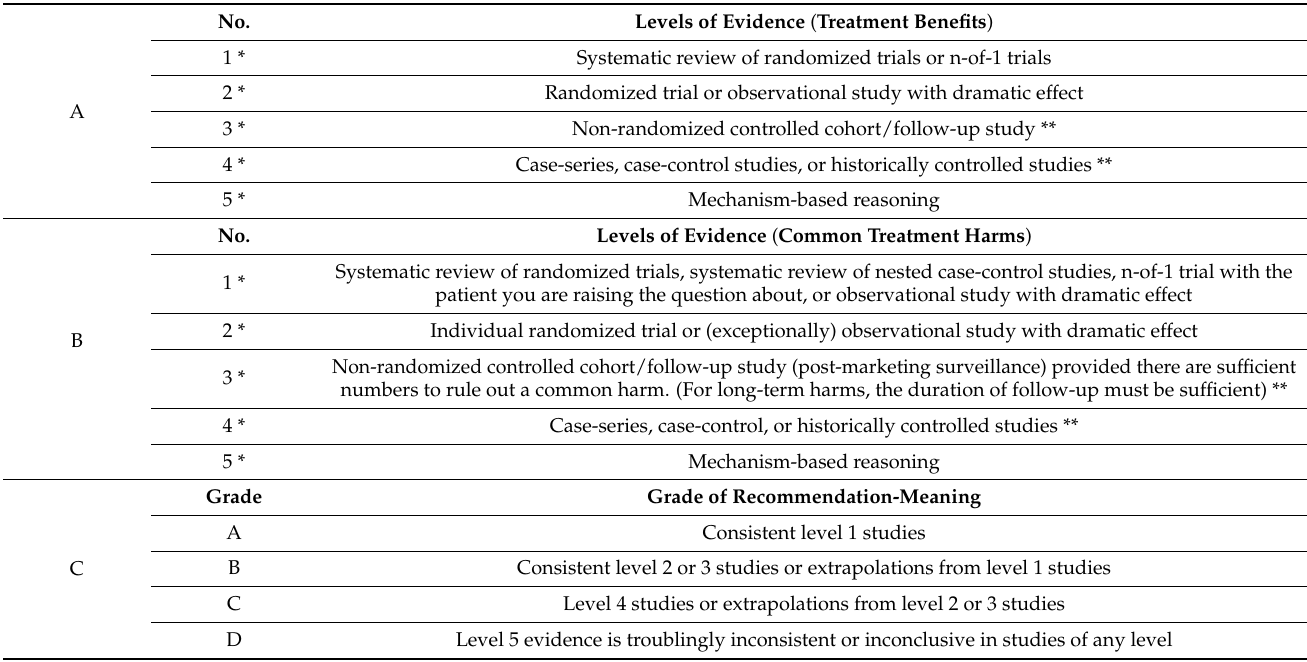
Table A2. ( A ) Levels of evidence (treatment benefits). ( B ) Levels of evidence (common treatment harms). ( C ) Grade of recommendation